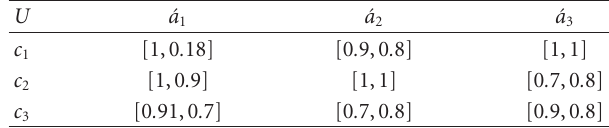
Table 5: Representation of false-membership function of ( (cid:2) G , B ).